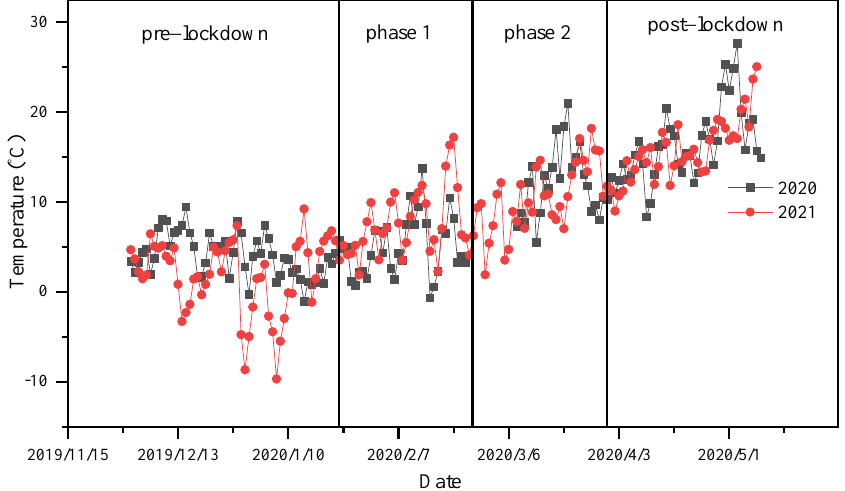
Figure 11. The variation of temperature (°C) from the weather station at Huaibei in 2020 and 2021.